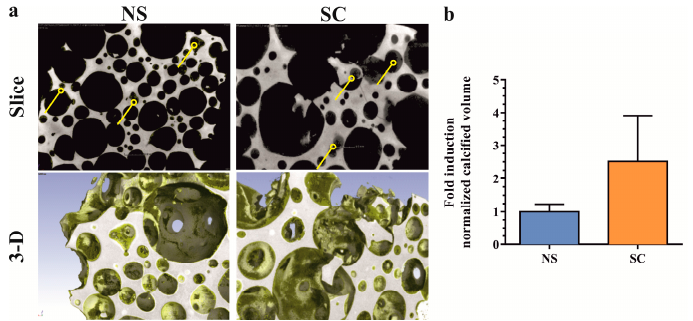
Figure 3. Quantification of de novo calcified tissue by micro-computed tomography. ( a ) Evidence of de novo calcified tissue formed in scaffold pores (arrowheads, upper panels). Three-dimensional visualization of ceramic (grey) and de novo calcified tissue (yellow) in explanted scaffold (lower panels). ( b ) Quantification of calcified tissue volume normalized by scaffold pore volume. Values are expressed as fold induction over non-sclerotic samples (means + SEM, n = 3 donors, duplicate implantations). NS: non-sclerotic, SC: sclerotic.